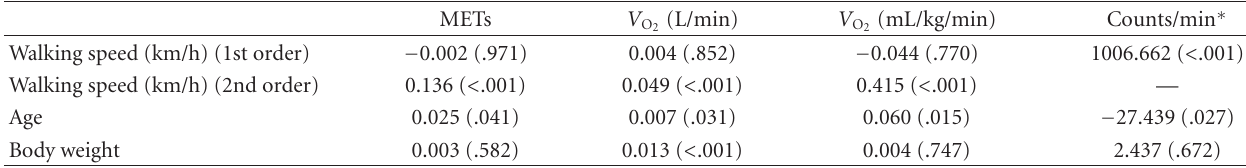
Table 3: The e ff ect (unstandardized regression coe ffi cients ( P value)) of walking speed, age, and body weight on metabolic cost and accelerometer counts during treadmill walking at 2, 3, 4, 5, and 6km/h. METs V O (L/min) V O (mL/kg/min) Counts/min ∗ 2 2 Walking speed (km/h) (1st order) − 0.002 (.971) 0.004 (.852) − 0.044 (.770) 1006.662 ( < .001) Walking speed (km/h) (2nd order) 0.136 ( < .001)